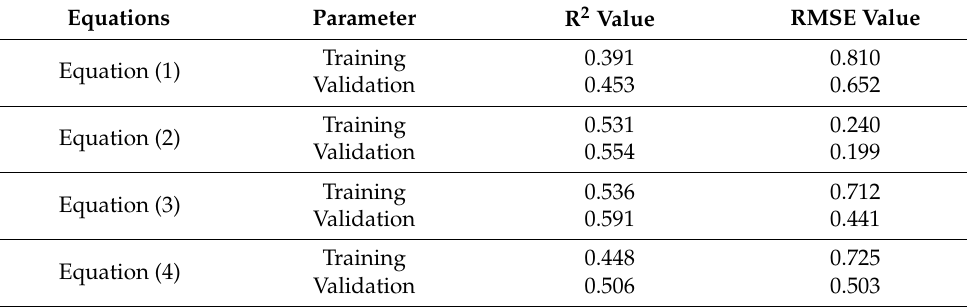
Table 8. Validation results of the soil TC content prediction